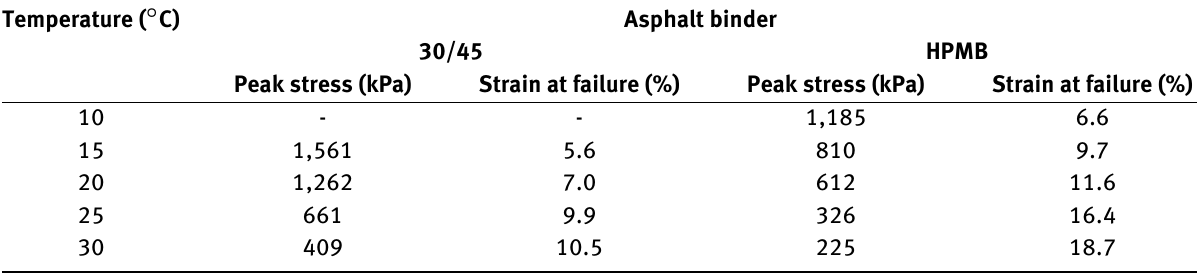
Table 3: Peak stress and respective strain values for 30/45 and HPMB binders at different temperatures Temperature ( ∘ C)